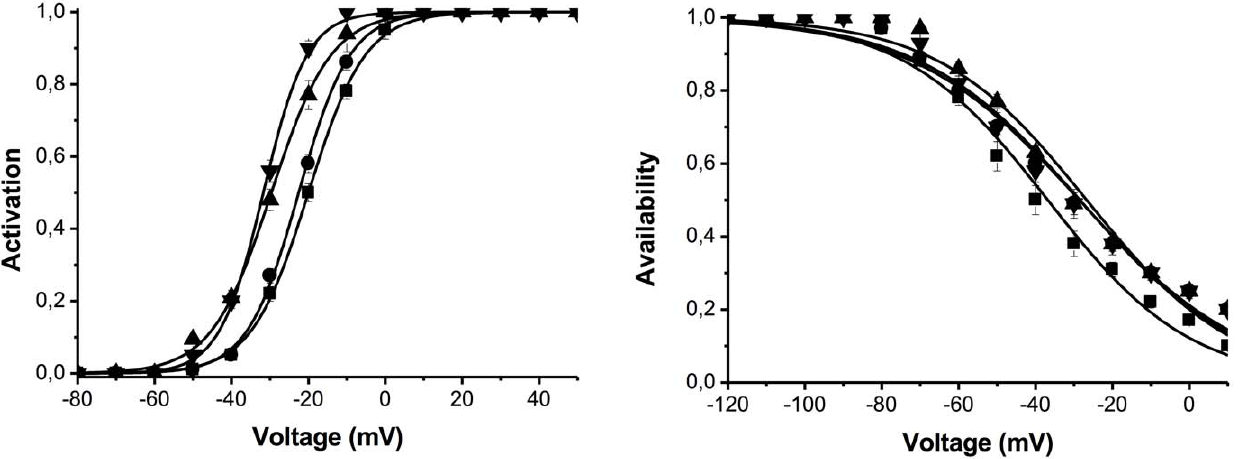
Figure 4. Effect of extracellular C18-CAR on hERG activation and availability. A . Activation curve in PSS (squares): V K = 2 20.3 6 0.1 mV (n=10); in the presence of 1 m M C18-CAR (circles): 2 22.8 6 0.1 mV (n=8); in the presence of 3 m M C18-CAR (diamonds): 2 30.0 6 0.3 mV (n=8) and in the presence of 10 m M C18-CAR (triangles): 2 31.9 6 0.9 mV (n=4). B . Availability curve in PSS (squares): V K = 2 40.9 6 2.3 mV (n=8); in the presence of 1 m M C18-CAR (circles): V K = 2 36.2 6 3.1 mV (n=8); in the presence of 3 m M C18-CAR (triangles): V 1/2 = 2 34.8 6 1.4 mV (n=8) and in the presence of 10 m M C18-CAR (diamonds): V 1/2 = 2 35.6 6 2.1 mV.